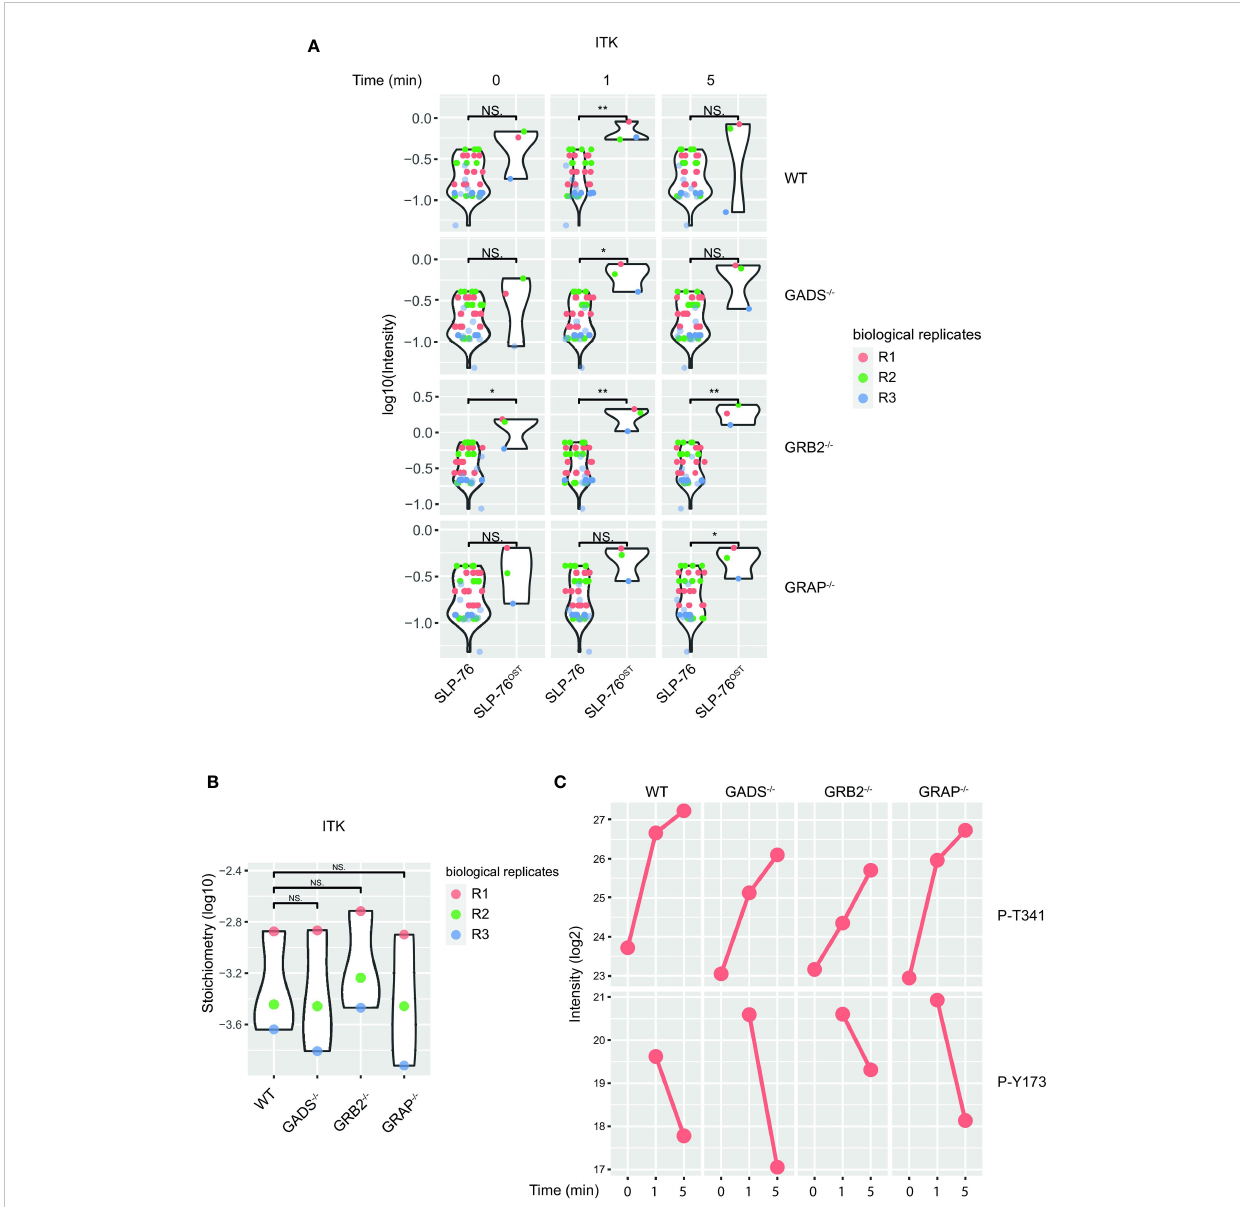
FIGURE 6 Preserved ITK-SLP76 interaction in the absence of GRB2-family adaptors. (A) The abundances of ITK was estimated in SLP76 OST AP-MS from cells that were left unstimulated (0) or stimulated for 1 or 5 min with anti-CD3 antibody in three independent biological replicates (R1, R2 and R3). (B) Comparison of ITK-SLP76 interaction stoichiometry in cells stimulated with anti-CD3 for 1 min. Imputed missing values are represented with lighter shaded dots. (C) MS intensities of speci fi ed phosphosites detected on the SLP76 OST molecules in experimental conditions described in (A) WT refers to the SLP76 OST variant while GADS -/- , GRB2 -/- and GRAP -/- refer to the SLP76 OST variants de fi cient for GADS (GRAP2), GRB2 and GRAP respectively. Normalized intensities (see Materials and Methods) from parental Jurkat (SLP76) and SLP76 OST cells were compared using a two-sided Welch t-test (symbols used according to the t-test P-value: N.S., P > 0.05; *P ≤ 0.05; **P ≤